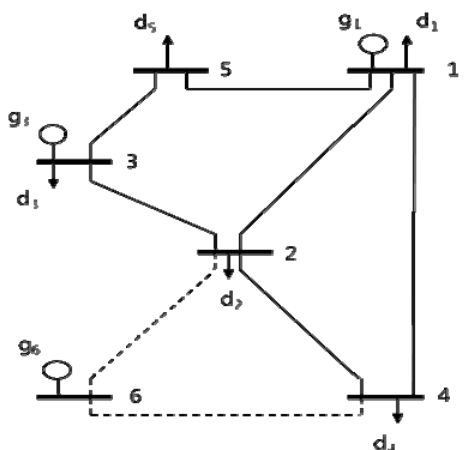
Figure 7. Initial configuration of Garver’s six-bus system. Table 1. Generation and load data.